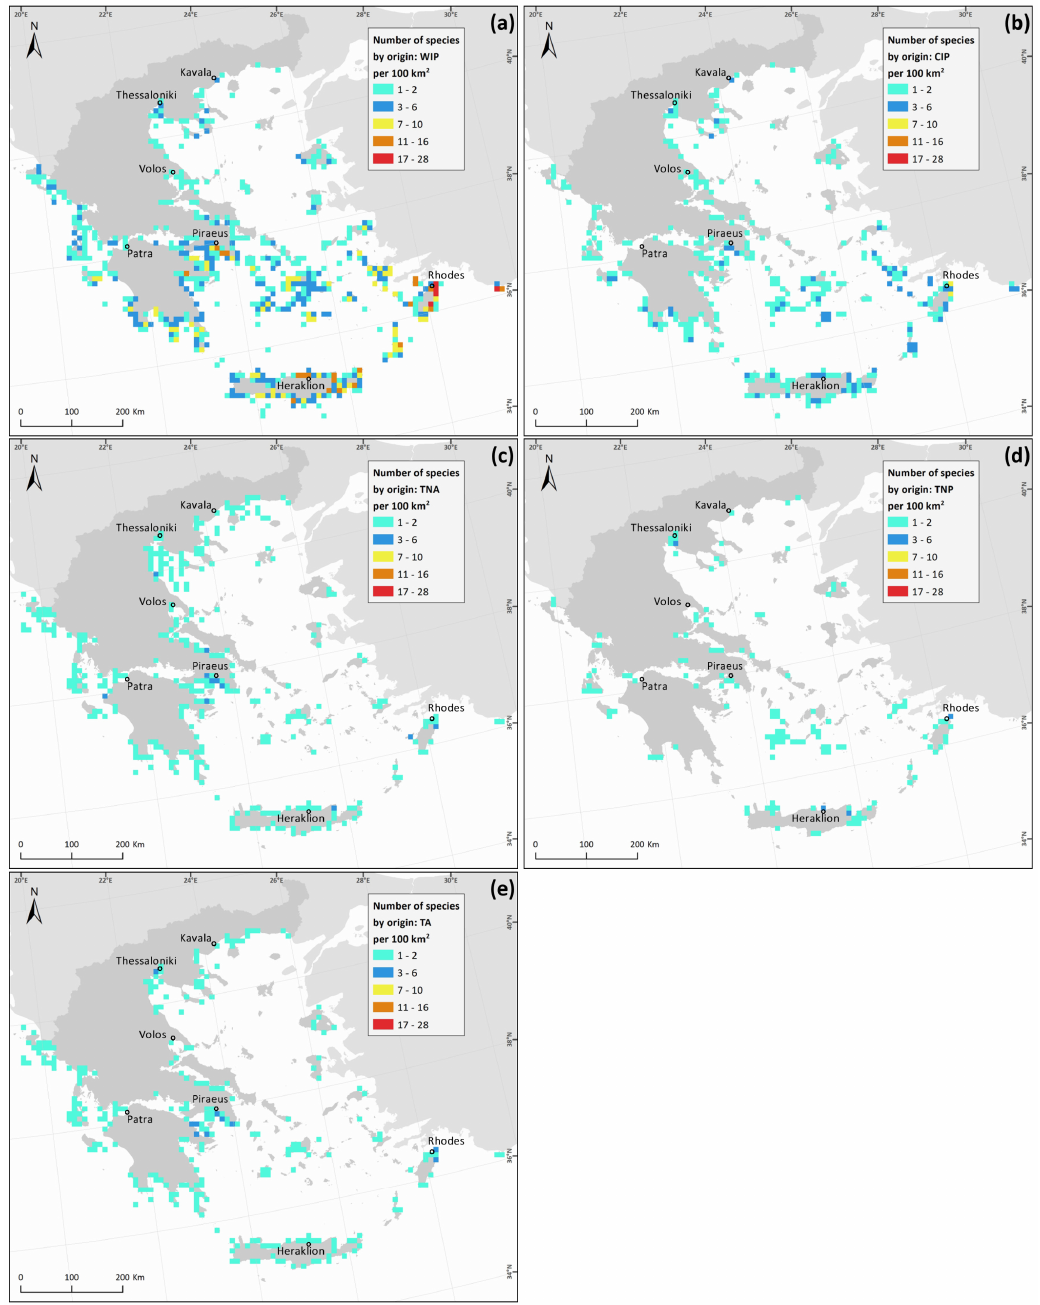
Figure 4. Map of the Greek Seas depicting the total number of ICAS according to their native distribution range—WIP: Western Indo ‐ Pacific ( a ), CIP: Central Indo ‐ Pacific ( b ), TNA: Temperate Northwest Atlantic ( c ), TNP: Temperate Northern Pacific ( d ), TA: Tropical Atlantic ( e ). Grid cells were produced using the 10 × 10 km EEA reference grid.